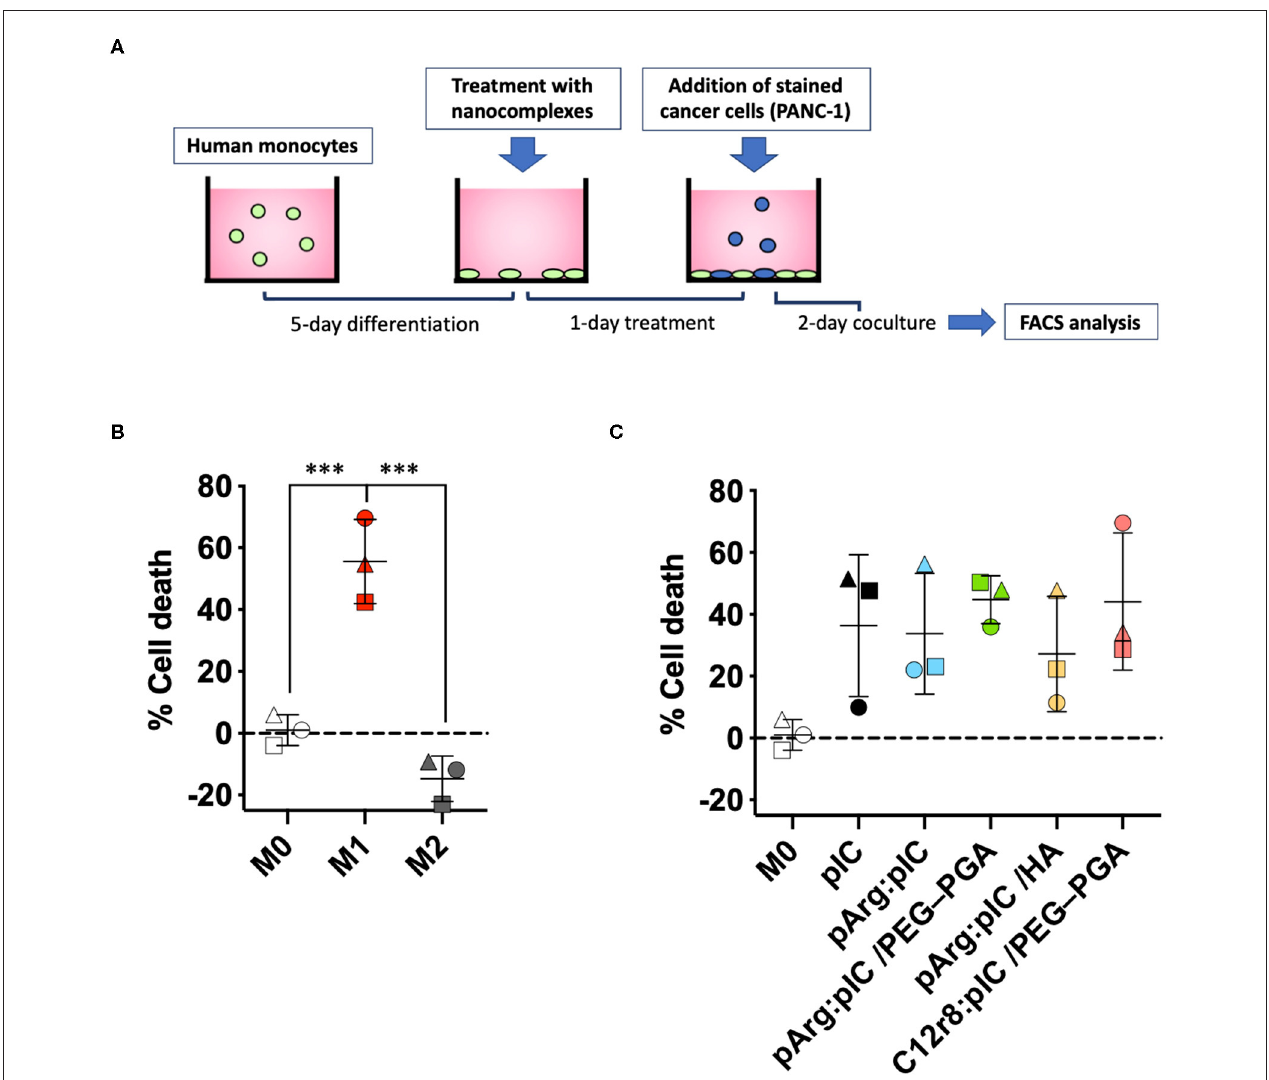
FIGURE 7 | Macrophage cytotoxicity toward PANC-1 cancer cells after pre-treatment with the different nanocomplexes. (A) Schematic representation of the in vitro model for the determination of the killing capacity of pre-treated macrophages. (B,C) % of cancer cell death caused by (B) the prototypic macrophages or (C) M0 macrophages pre-treated with free or nanocomplexed poly(I:C). Poly(I:C) was used at the final dose of 5 µ g/mL. Each symbol shape represents a different donor. Values represent mean ± SD ( n ≥ 3). Statistical comparison was done using an ordinary one-way ANOVA followed by a Tukey’s multiple comparison test between groups. Statistically significant differences are represented as *** p < 0.005. C12r8, laurate-octaarginine; HA, hyaluronic acid; pArg, poly-arginine; PANC-1, pancreatic cancer cells; PEG–PGA, pegylated polyglutamic acid; pIC,